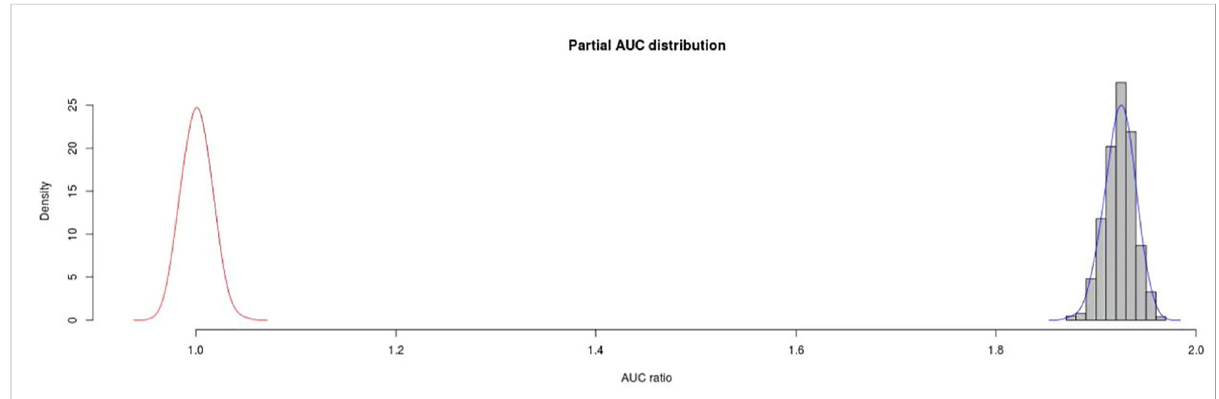
FIGURE 3 The results of